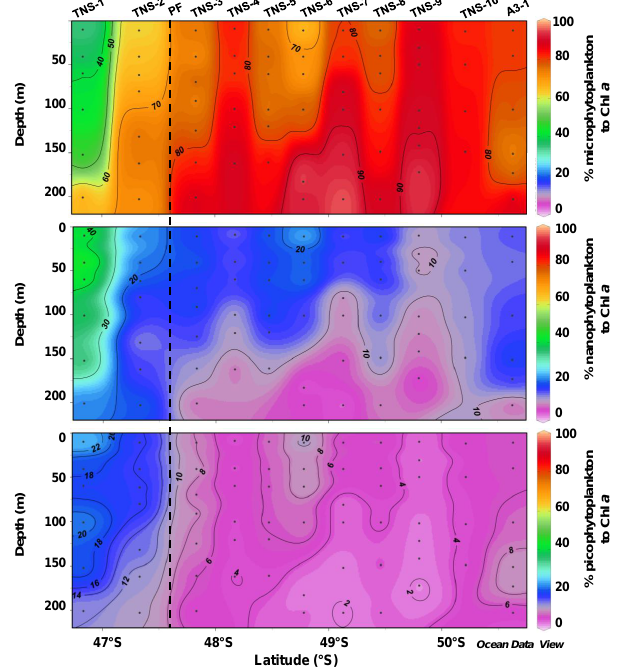
Ocean Data View Latitude ( S) Figure 5. Figure 5. Vertical distribution of micro-, nano- and picophytoplank- ton community contributions to total biomass along the TNS tran- sect. The dashed line represents the approximate location of the southern branch of the polar front